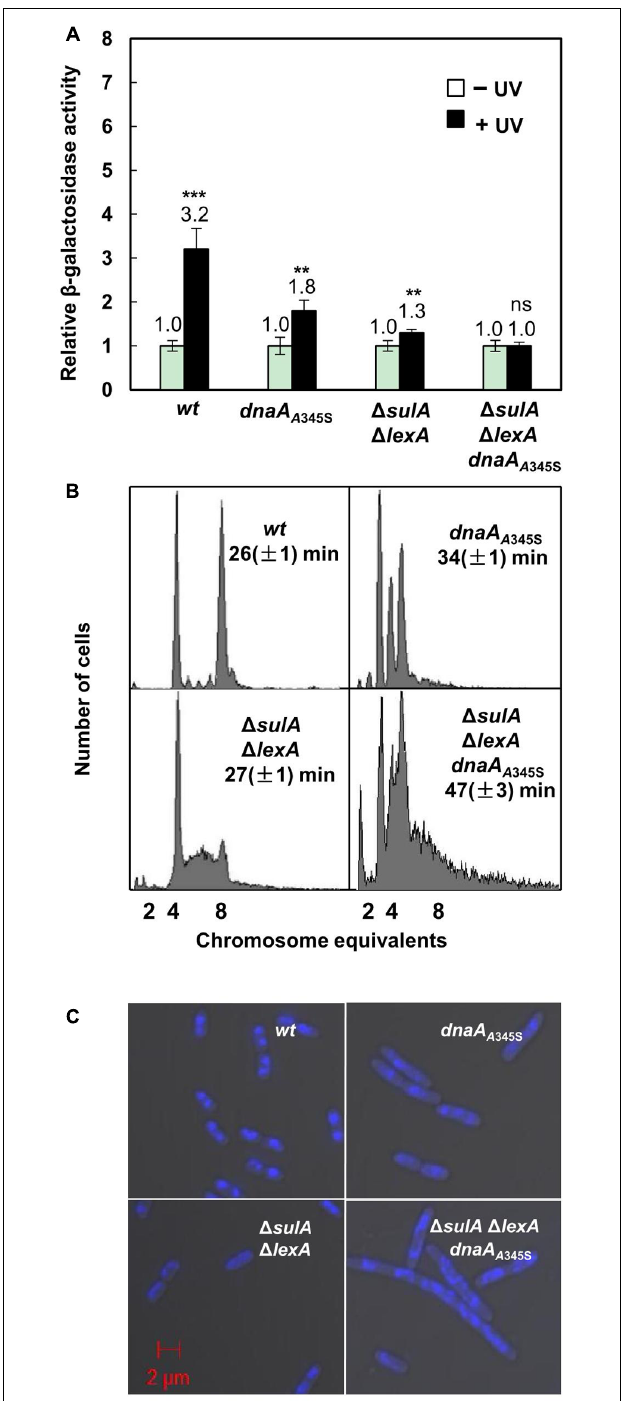
FIGURE 6 | The simultaneous absence of LexA- and DnaA-repression leads to formation of elongated cells with incomplete replication and aberrant nucleoids. (A) Exponentially growing wild-type and mutant cells mentioned in the legend to Figure 1A except (cid:49) sulA in ABTGcasa medium at 37 ◦ C were treated with UV (50 J/M 2 ) at OD 450 = 0.08. The expression of the uvrB gene was assayed as the β -galactosidase activity described in the legend to Figure 1 . The filled bars represent expression after UV treatment relative to